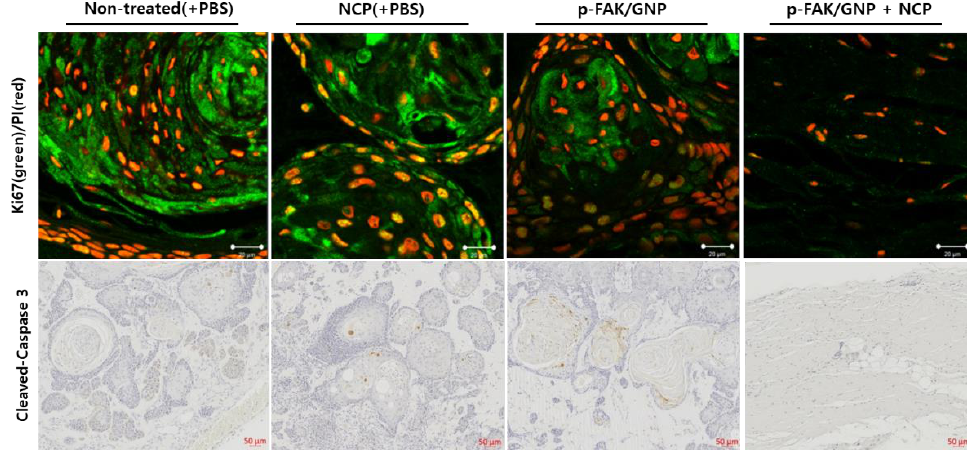
Figure 7. The proliferating and apoptotic cells are not detected in tissues isolated from the p- FAK/GNP+NCP group. (Upper panel) The results of the immunofluorescence assay against Ki67 protein using the tissues isolated from each group. The nuclear was counterstained with PI. Scale bar: 20 μm. (Lower panel) The results of IHC against cleaved caspase 3 protein. The nuclear was stained with hematoxylin. Scale bar: 50 μm.